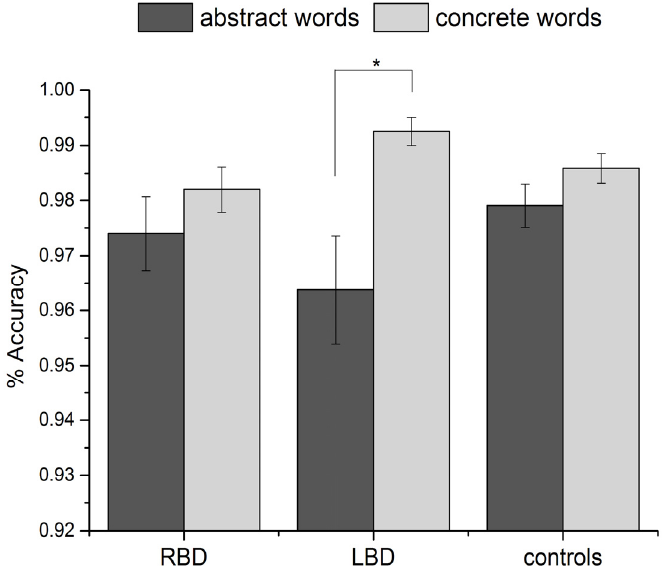
Figure 1. Percentage of correct responses for abstract and concrete words in RBD, temporal LBD and controls. Error bars represent standard errors of the